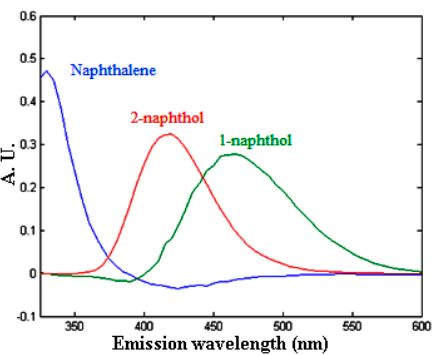
Figure 4. Emission fluorescence spectra of naphthalene, 1-naphthol, and 2-naphthol excited by the wavelength of 220, 256, and 246 nm, respectively.